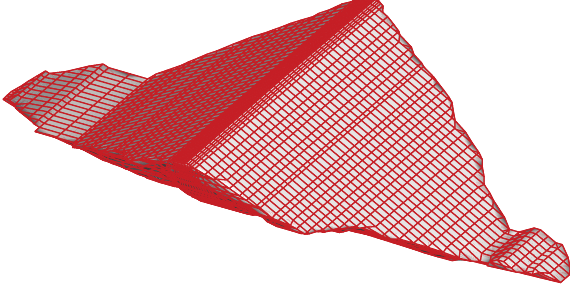
Figure 4: 3D FEM mesh of Nuozhadu earth-core rockfill dam.